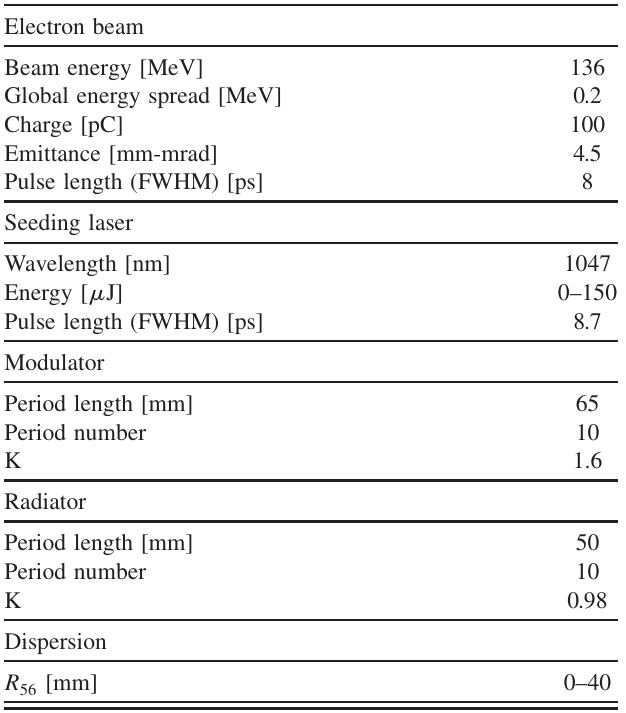
TABLE I. Parameters of SDUV-FEL with CHG